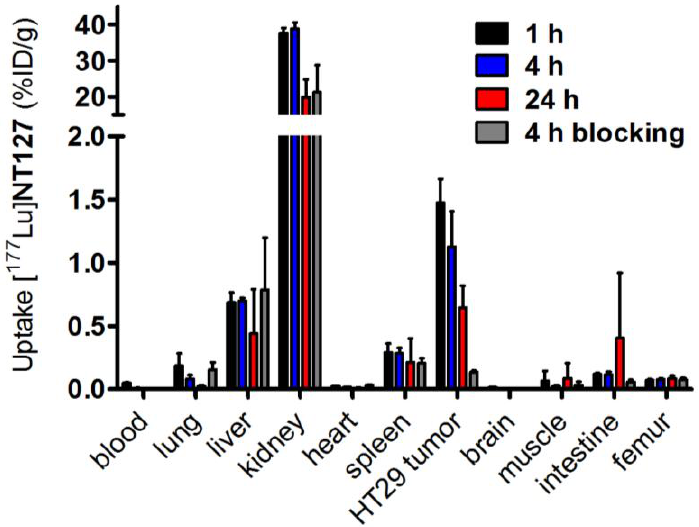
Figure 3. Biodistribution of [ 177 Lu] NT127 in HT29 xenografted nude mice 1 h , 4 h and 24 h after injection and 4 h after injection of [ 177 Lu] NT127 together with NT4 (100 µg/mouse, ―blocking‖). Each data point represents the mean ± standard deviation of tissue samples from two